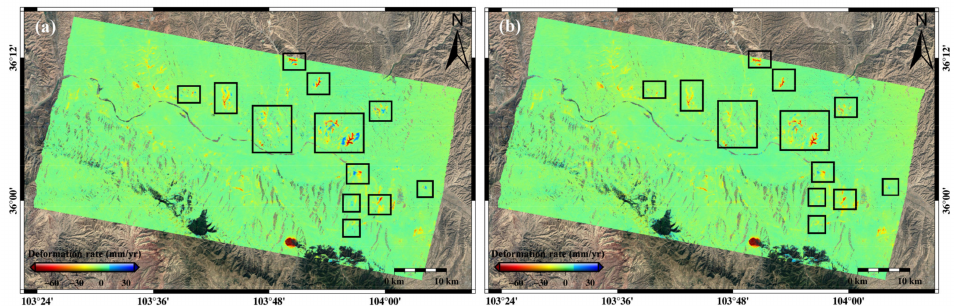
Figure 8. Displacement rates of the study area between December 2015 and December 2017 derived from descending Sentinel-1 images processed without ( a ) and with ( b ) DEM errors correction.